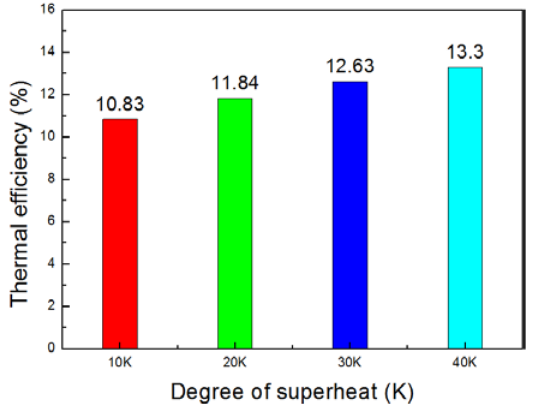
Figure 7. Thermal efficiency for different degrees of